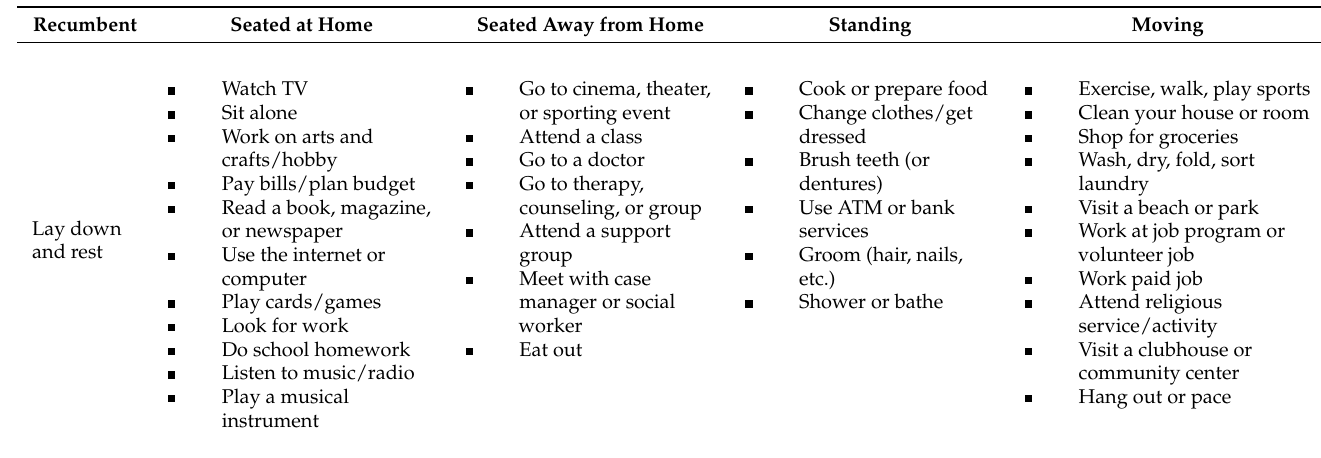
Table 1. Categorization of EMA-reported